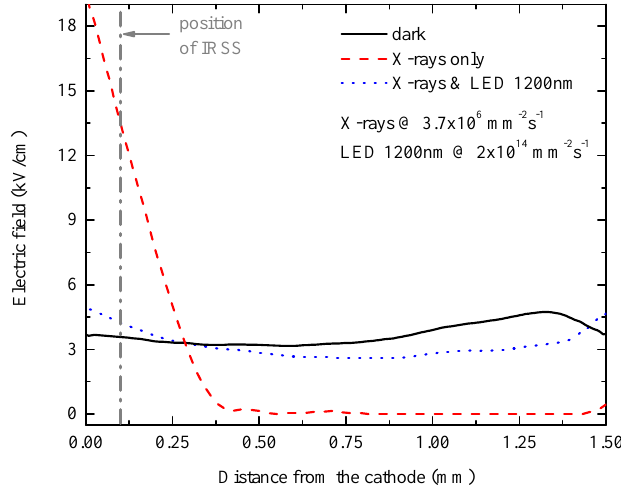
Figure 2. Electric field profiles between electrodes of planar detector Sample 1 biased at 500 V measured by the cross-polarizer technique based on the Pockels effect. The vertical dash-dotted line shows the depth below the cathode used for IRSS